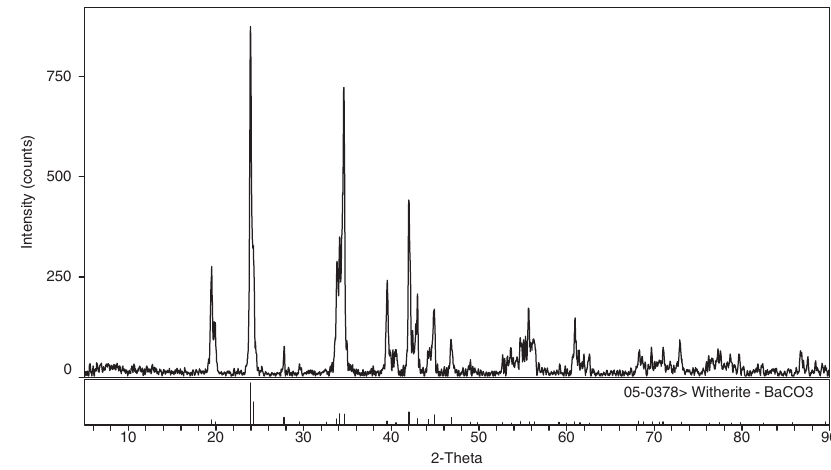
Figure 7: XRD pattern of BaCO 3 particles prepared under optimal experimental conditions.